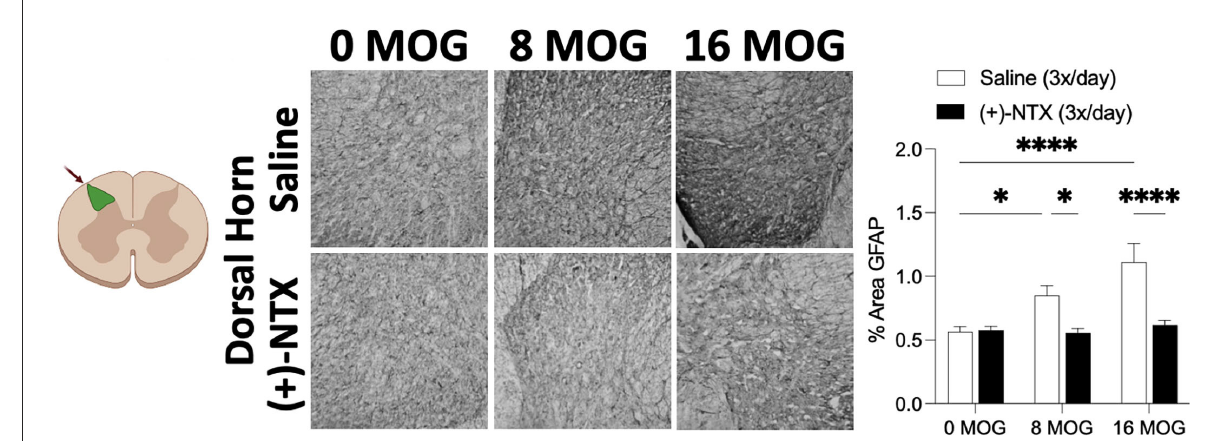
FIGURE8 Myelin oligodendrocyte glycoprotein (MOG) induces lumbar spinal cord dorsal horn GFAP immunoreactivity that is reversed by daily systemic administration of the TLR2–TLR4 antagonist ( + )-Naltrexone [( + )-NTX]. Sprague-Dawley (SD) from Experiment 2 received intradermal low-dose (0, 8, and 16 µ g) myelin oligodendrocyte glycoprotein (MOG). Spinal cord tissue was collected on day 30 post-MOG administration and during 13 days of daily ( + )-NTX administration. Both doses of MOG increased expression of the astrocyte immunoreactivity marker GFAP in dorsal horn of lumbar spinal cord, which was reversed to 0 µ g MOG control levels by ( + )-NTX administration. Main effects of MOG [ F (2,80) = 10.02; p = 0.0001], ( + )-NTX [ F (1,80) = 24.89; p < 0.05], and interaction between MOG and ( + )-NTX [ F (2,80) = 7.79; p < 0.001]. N = 5–8/group with 2–4